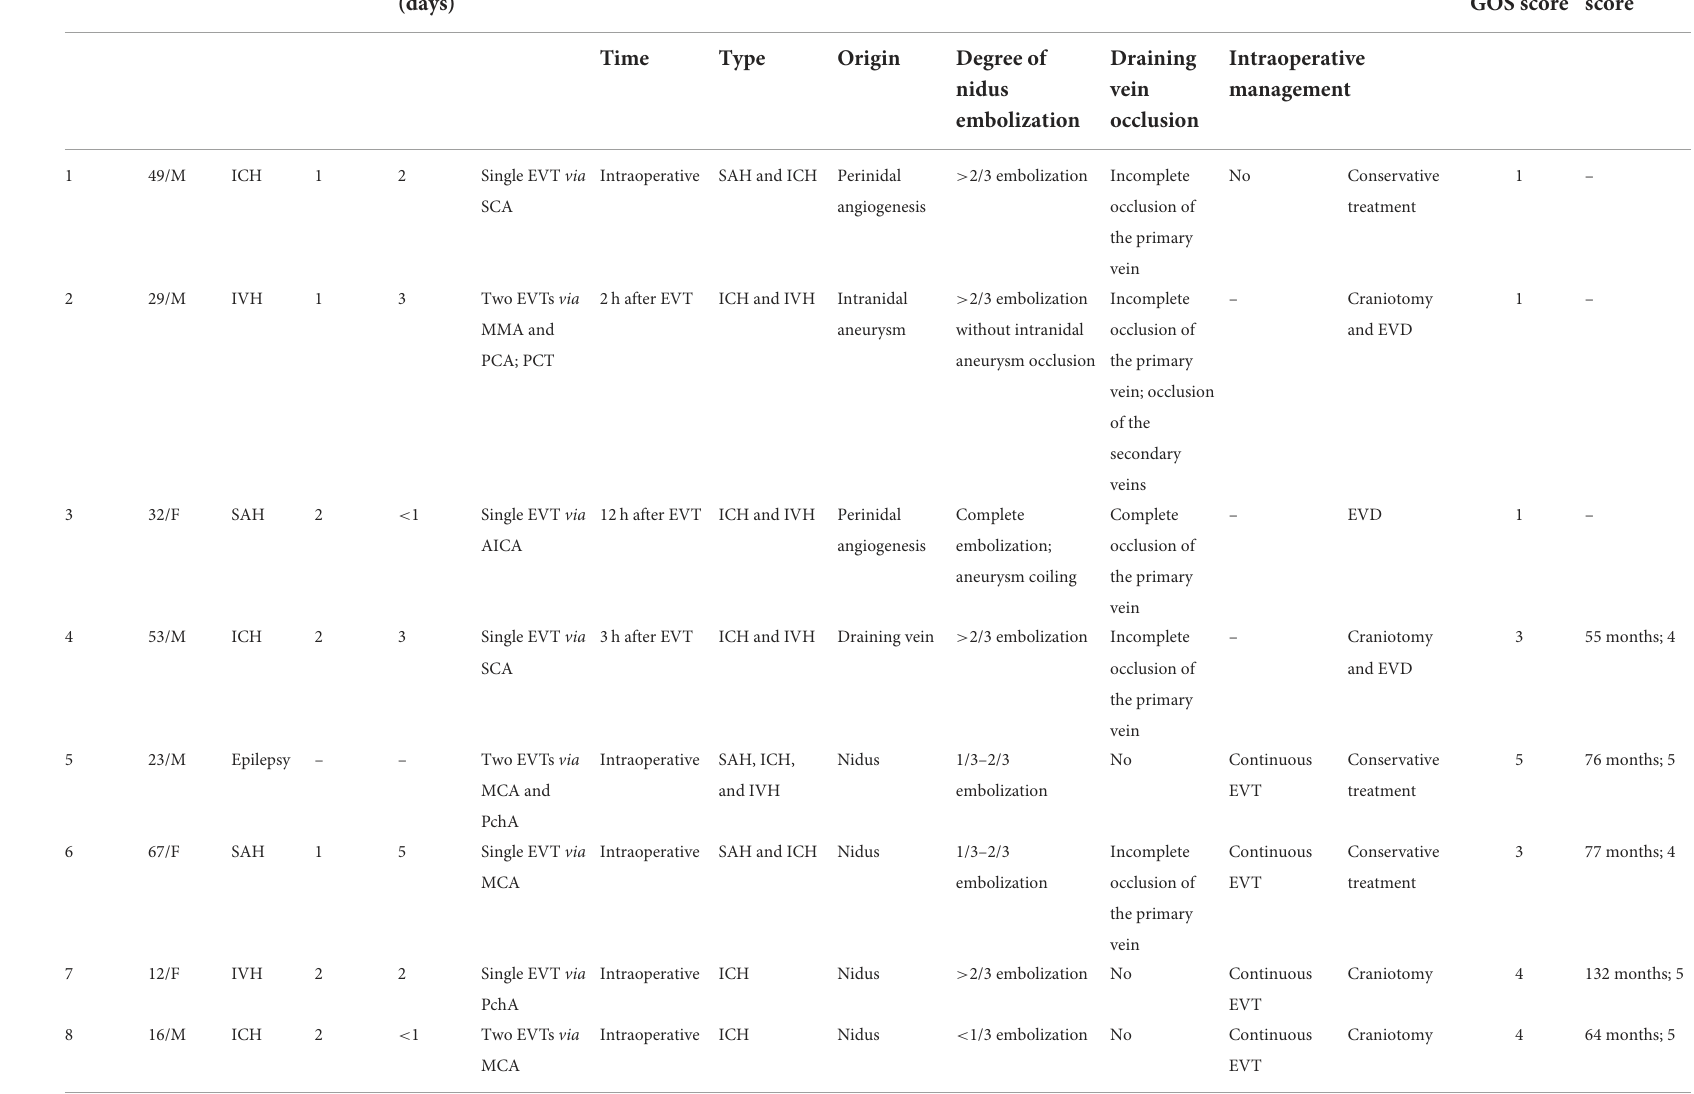
TABLE 1 Clinical data of this